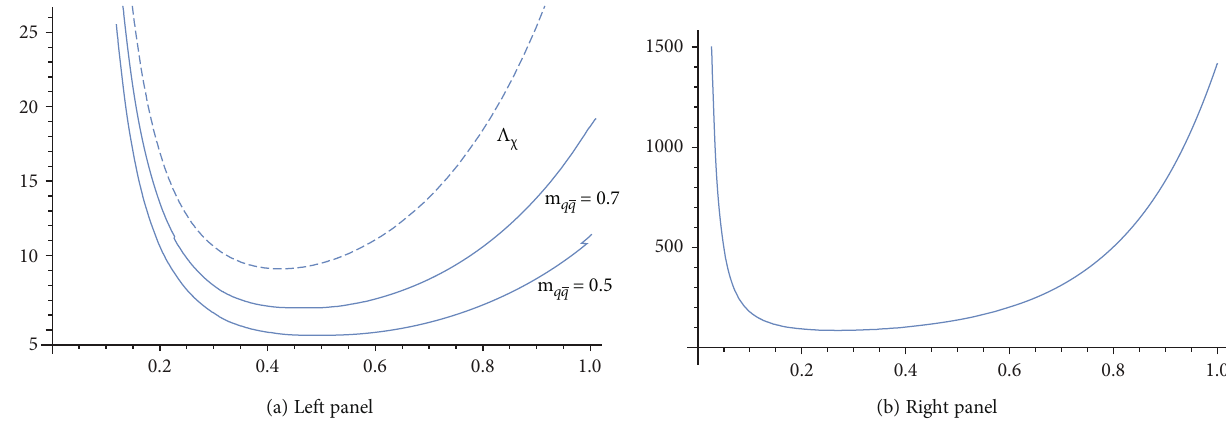
Þ against ( r , m q (cid:1) q